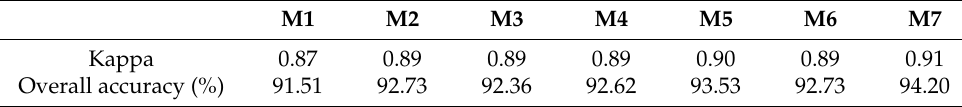
Table 4. Accuracy results for the pixel-based classification